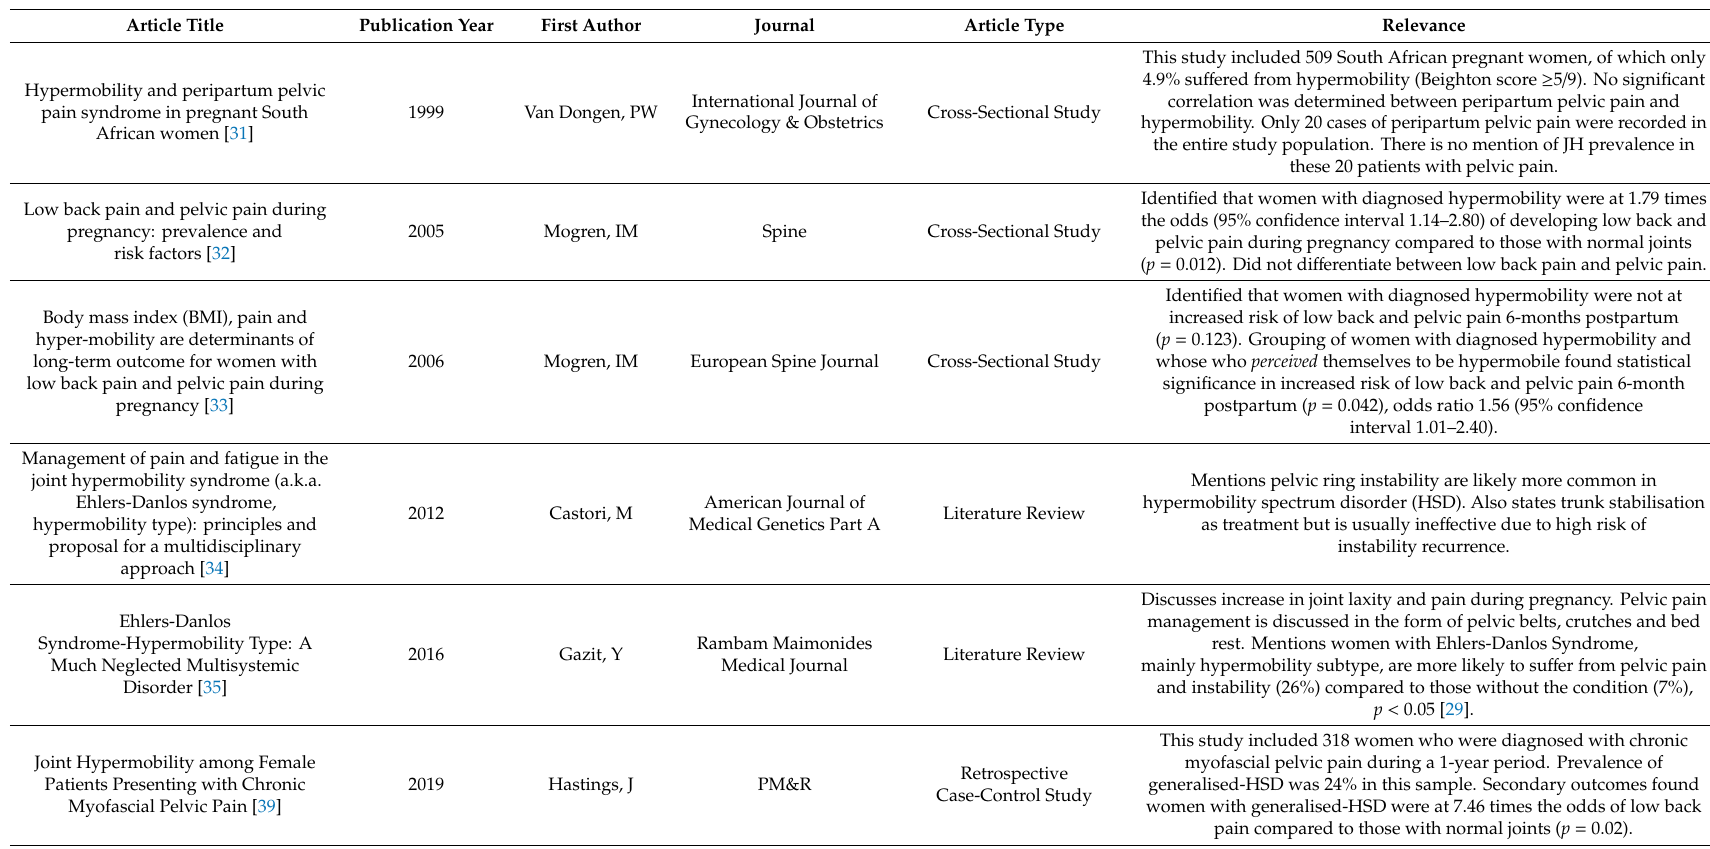
Table 3. Summary of included articles from literature